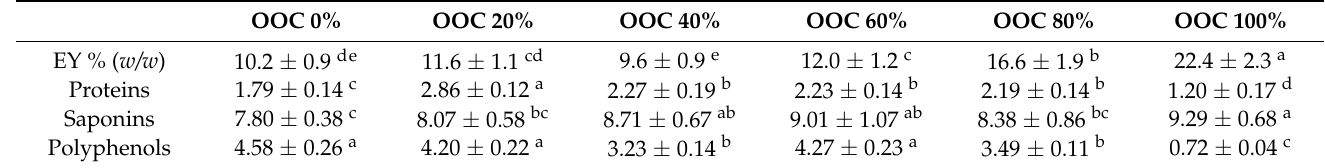
Table 1. Extraction yields (EY) and content in surface-active components (%, w/w ) of olive oil cake (OOC) extracts prepared using various aqueous-ethanolic solvent mixtures. Means in the same line followed by the same letter are not significantly different ( α =